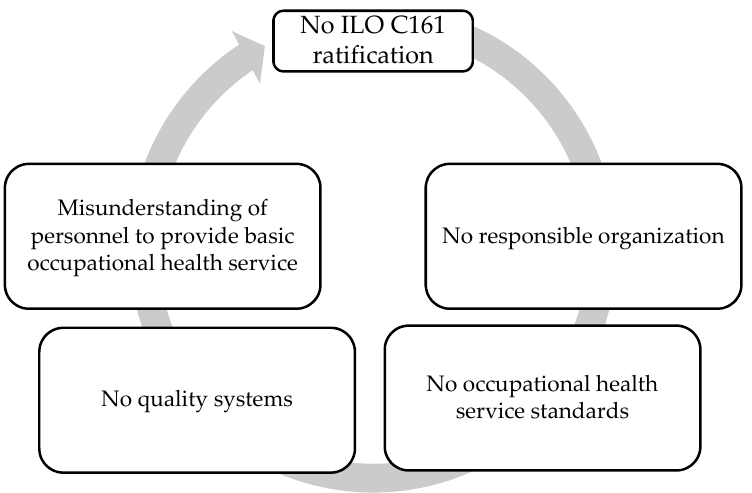
Figure 4. The cycle of limitations to developing occupational health services.